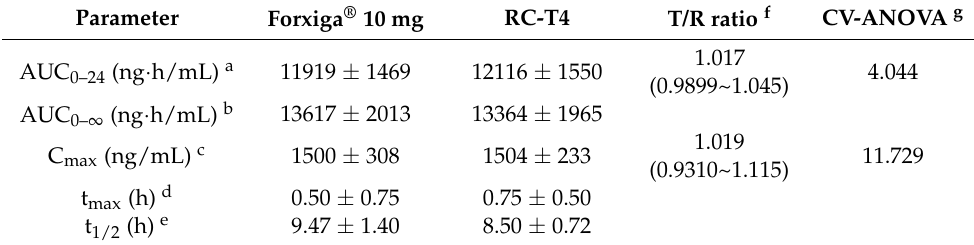
Table 4. PK parameters of dapagliflozin (DAP) after oral administration of Forxiga ® 10 mg and RC-T4 in beagle dogs.